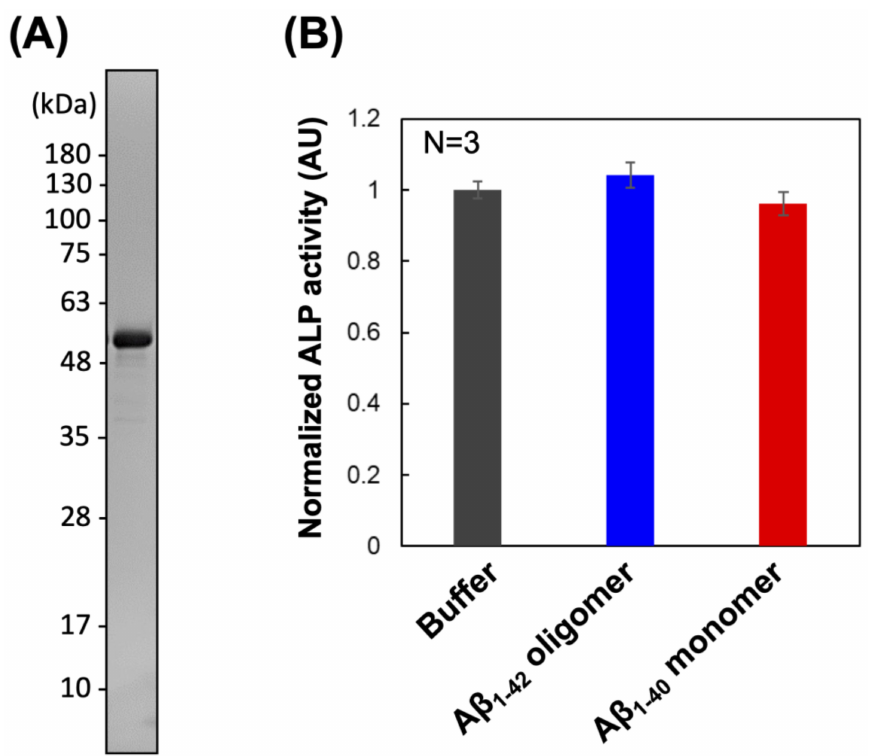
Figure 1. ( A ) SDS-PAGE analysis of PrP–ALP purified with affinity chromatography via StrepTag II. ( B ) Normalized enzymatic activity of PrP–ALP in the presence of A β oligomers. The data are shown as the mean ± SD in the graph ( n = 3). Additionally, 100% of normalized ALP activity (AU) represents the ALP activity when incubated PrP–ALP with the solvent control (PBS buffer).